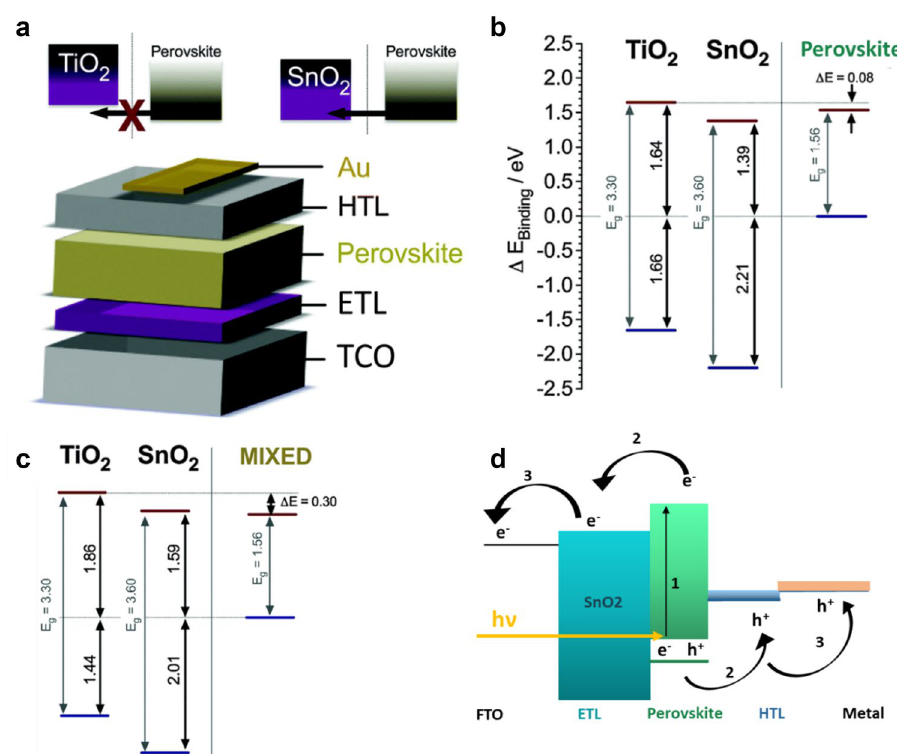
Fig. 2 a TiO 2 and SnO 2 energy levels, b electron injection potentials, c band-gap position of SnO 2 , and d band-gap posi- tion [17, 18]